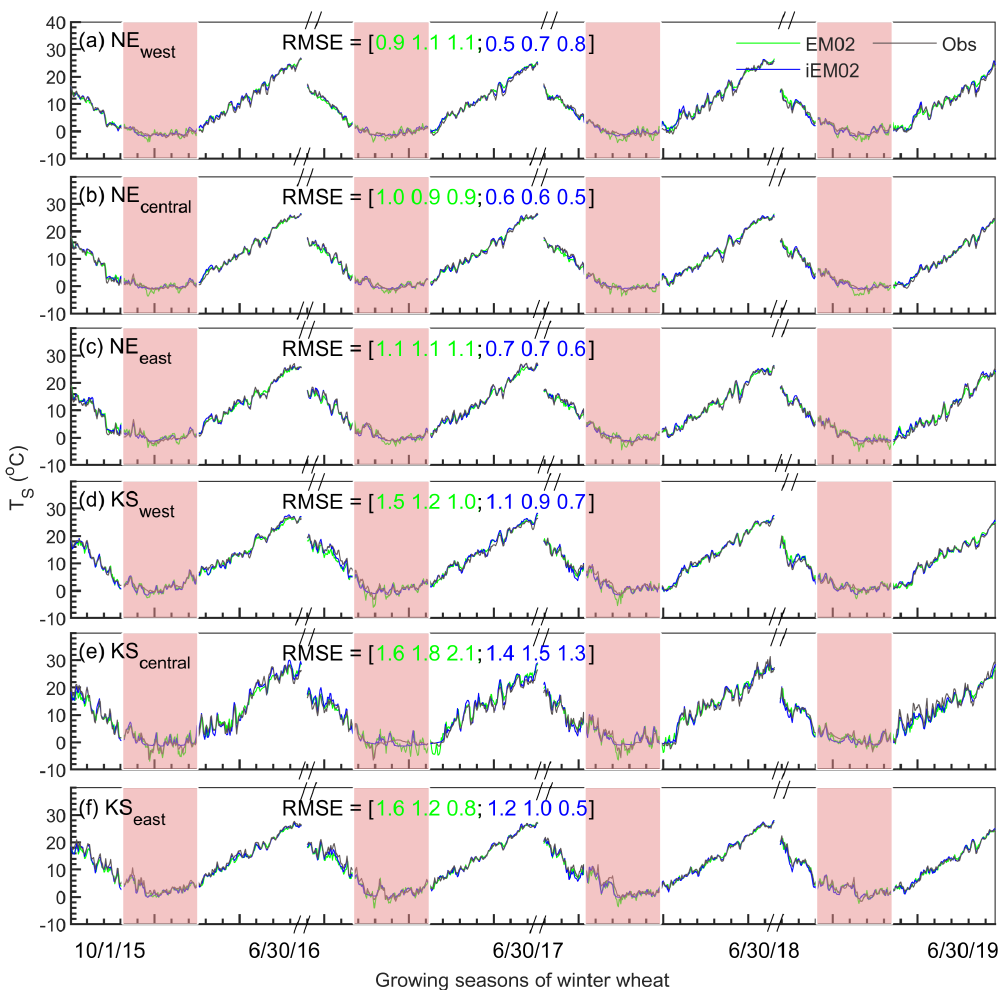
Figure 8. Daily soil temperature comparison between the observed (gray line), original model (EM02; green line), and improved model (iEM02; blue line) in western ( > 100 ◦ W), central (between 97 and 100 ◦ W), and eastern ( < 97 ◦ W) Nebraska (a–c) and Kansas (d–f) during the winter wheat growing seasons from 2015 to 2019. RMSE is the root mean square error (degrees Celsius). The values in brackets refer to both the RMSE values of the original model (green numbers) and the improved model (blue numbers) during the periods of October– November, December–February, and March–June, respectively. Shaded areas highlight the winter season (December–February).